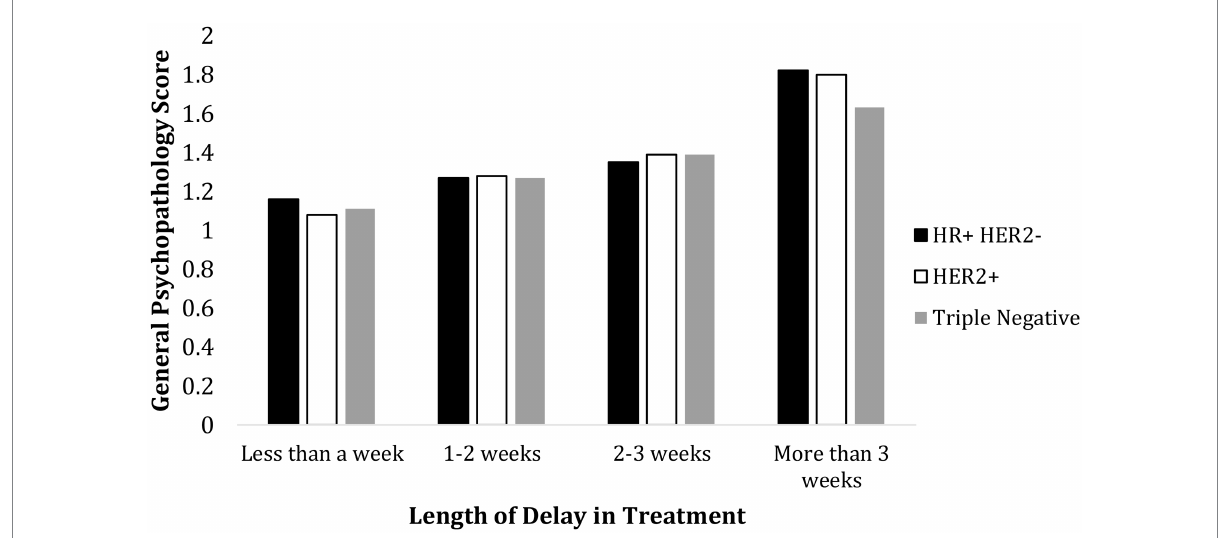
FIGURE 2 Psychological effect of treatment delay and molecular types. Molecular type did not have a significant effect on general psychopathology score, and there was no interaction of molecular type and length of treatment delay on the general psychological